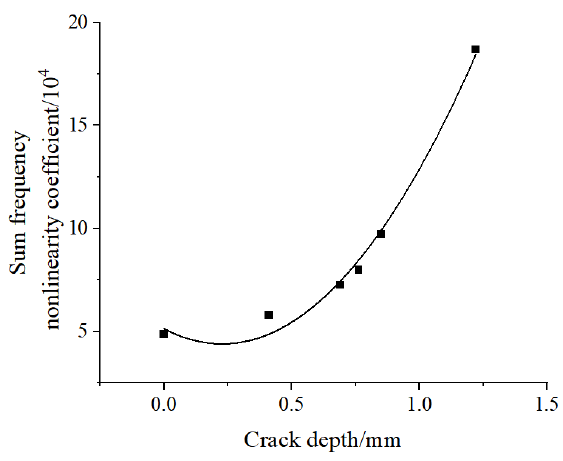
Figure 14. Relation between sum frequency and crack depth.